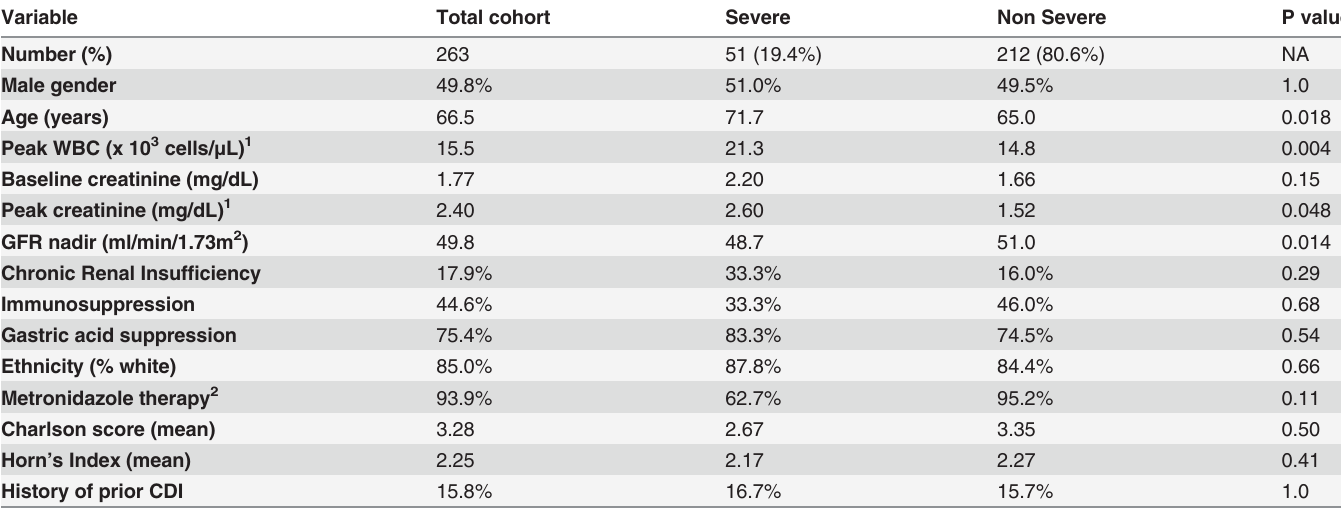
Table 1. Characteristics of Boston patients with severe and non-severe CDI (univariate analysis).